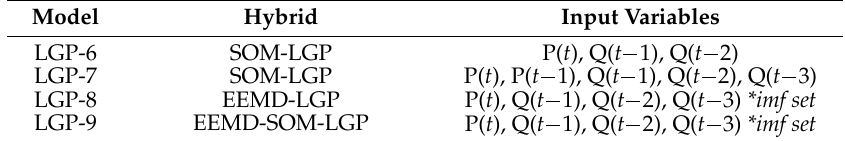
Table 4. Output and Input variables for EEMD-SOM-LGP models designed to predict ahead (LGP-10).